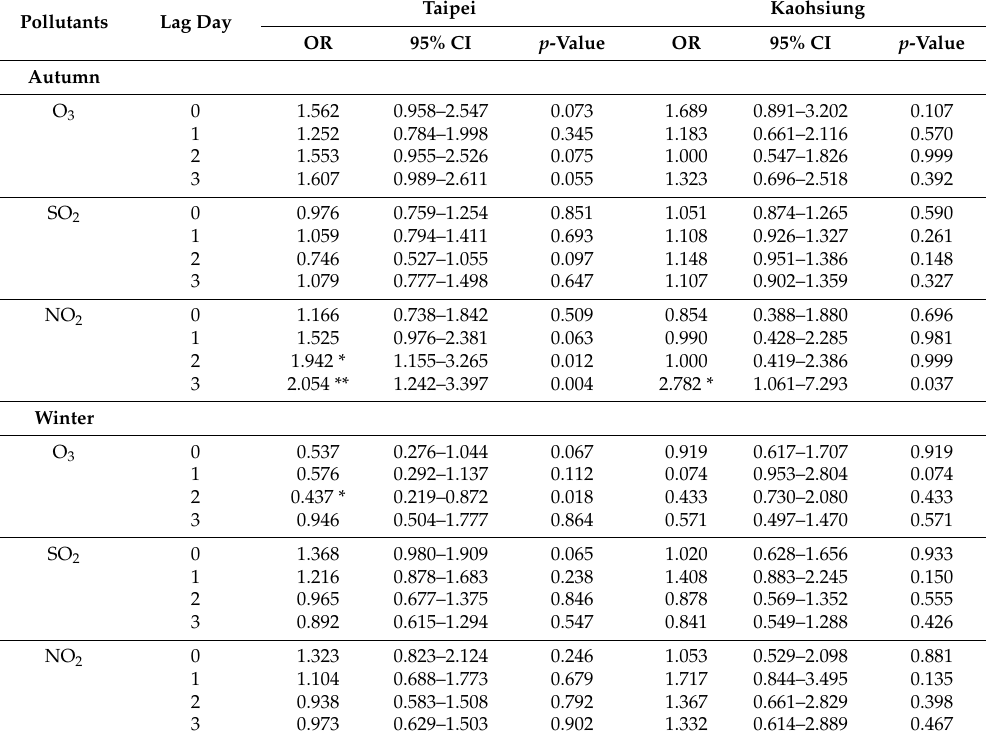
Table 8. Association between air pollution and childhood asthma in autumn and winter, adjusted for PM